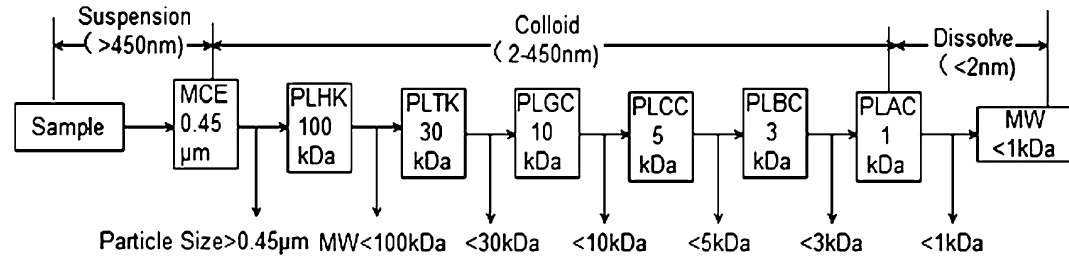
Fig. 1 Schematic view of continuous filtration